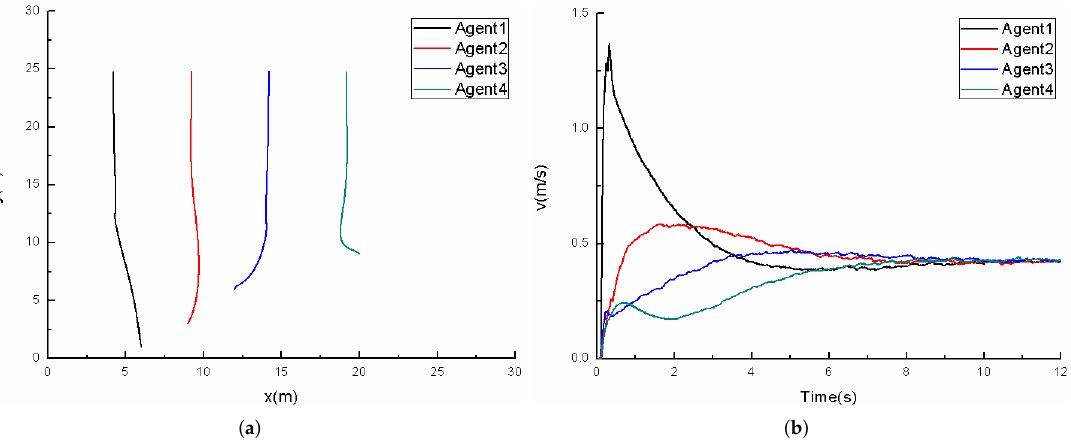
Figure 7. Position and velocity trajectories of second-order differential robot system (27) ( τ ij ( k ) (cid:54) = 0). ( a ) Position trajectories. ( b ) Velocity